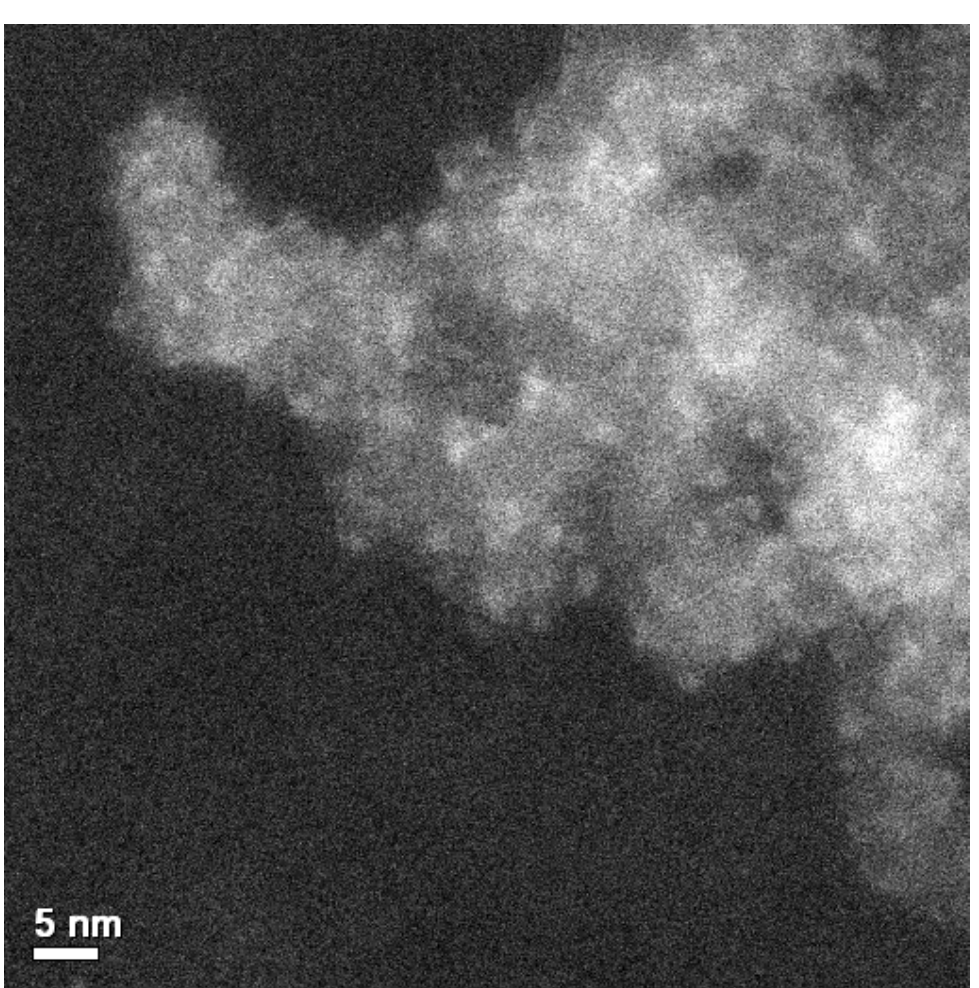
Figure 4. Annular dark field micrograph of the VOx/10ZrOx/S catalyst.